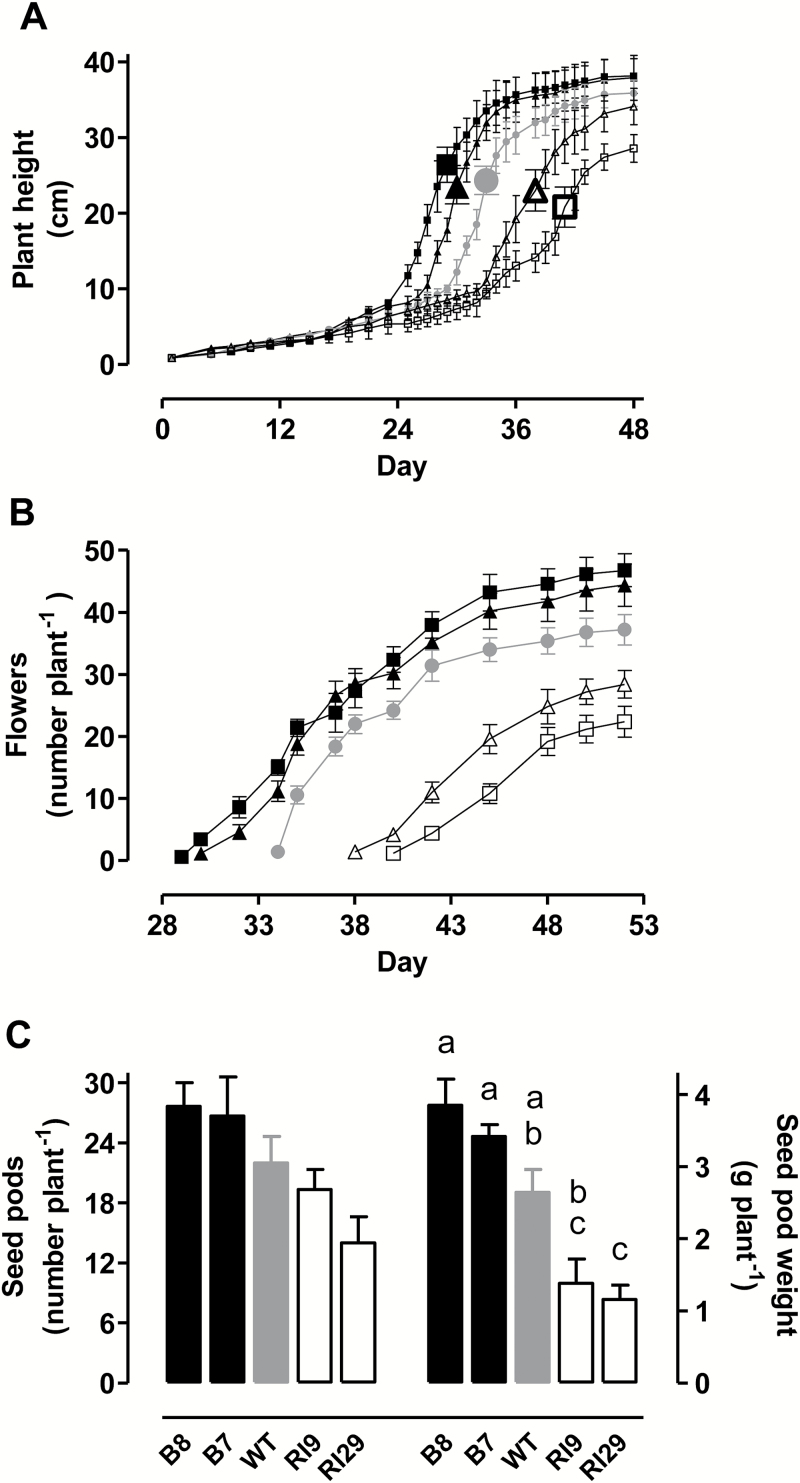
Tobacco growth and development during a prolonged water deficit. (A) Plant height over time. (B) Total number of flowers emerged over time. (C) Total number of seed pods (left axis and data set) and total DW of seed pods (right axis and data set). In (A, B) data are presented for WT (gray circle), AOX overexpressors (B7, closed triangle, B8, closed square), and AOX knockdowns (RI9, open triangle; RI29, open square), and are the mean±SE of three to five independent experiments (n=3–5). The large symbols in (A) denote the day when first flower(s) appeared. In (C) the data were collected following a water deficit experiment extended until day 92, when all plants were completely senesced and dry; and data are the mean±SE of three independent experiments (n=3). Within each data set, plant lines not sharing a common letter are significantly different from one another (P<0.05). In data sets without letters, there are no significant differences across plant lines.